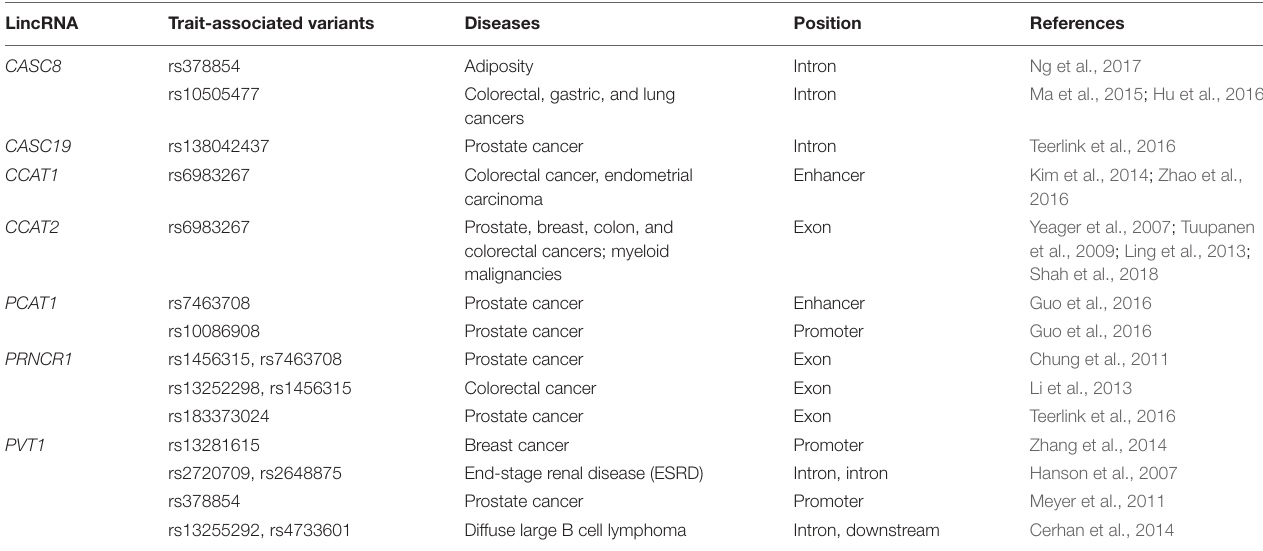
FIGURE 1 | (A) Genomic distribution of single-nucleotide variants in cancers; a majority of cancer-associated single-nucleotide variants (SNVs) [single-nucleotide polymorphisms (SNPs)] are found in the intergenic or intronic regions, and only small numbers are located in protein-coding regions of the human genome. (B) Classification of long non-coding RNA (lncRNA) transcripts; long intergenic non-protein coding RNA (lincRNA) is a major subtype of lncRNA. TABLE 1 | Overviews of trait-associated variants on the chr8q24